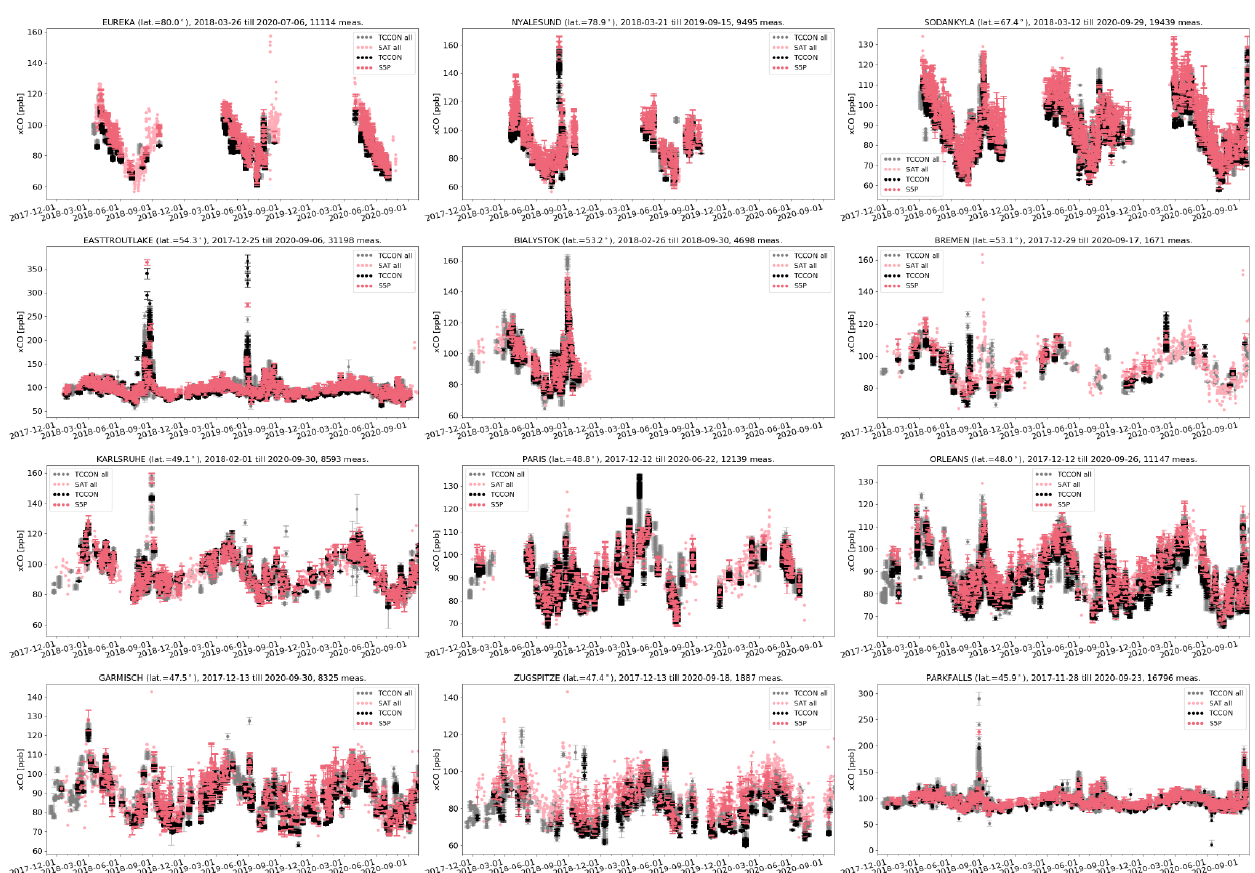
Figure 19. XCO time series for all unscaled TCCON data (grey), all S5P data (light red), S5P data co-located with TCCON data (red) and co-located unscaled TCCON data with a priori alignment (black) at each site ordered with decreasing latitude. Spatial co-location with radius of 50km and time of ± 1h around the satellite overpass was